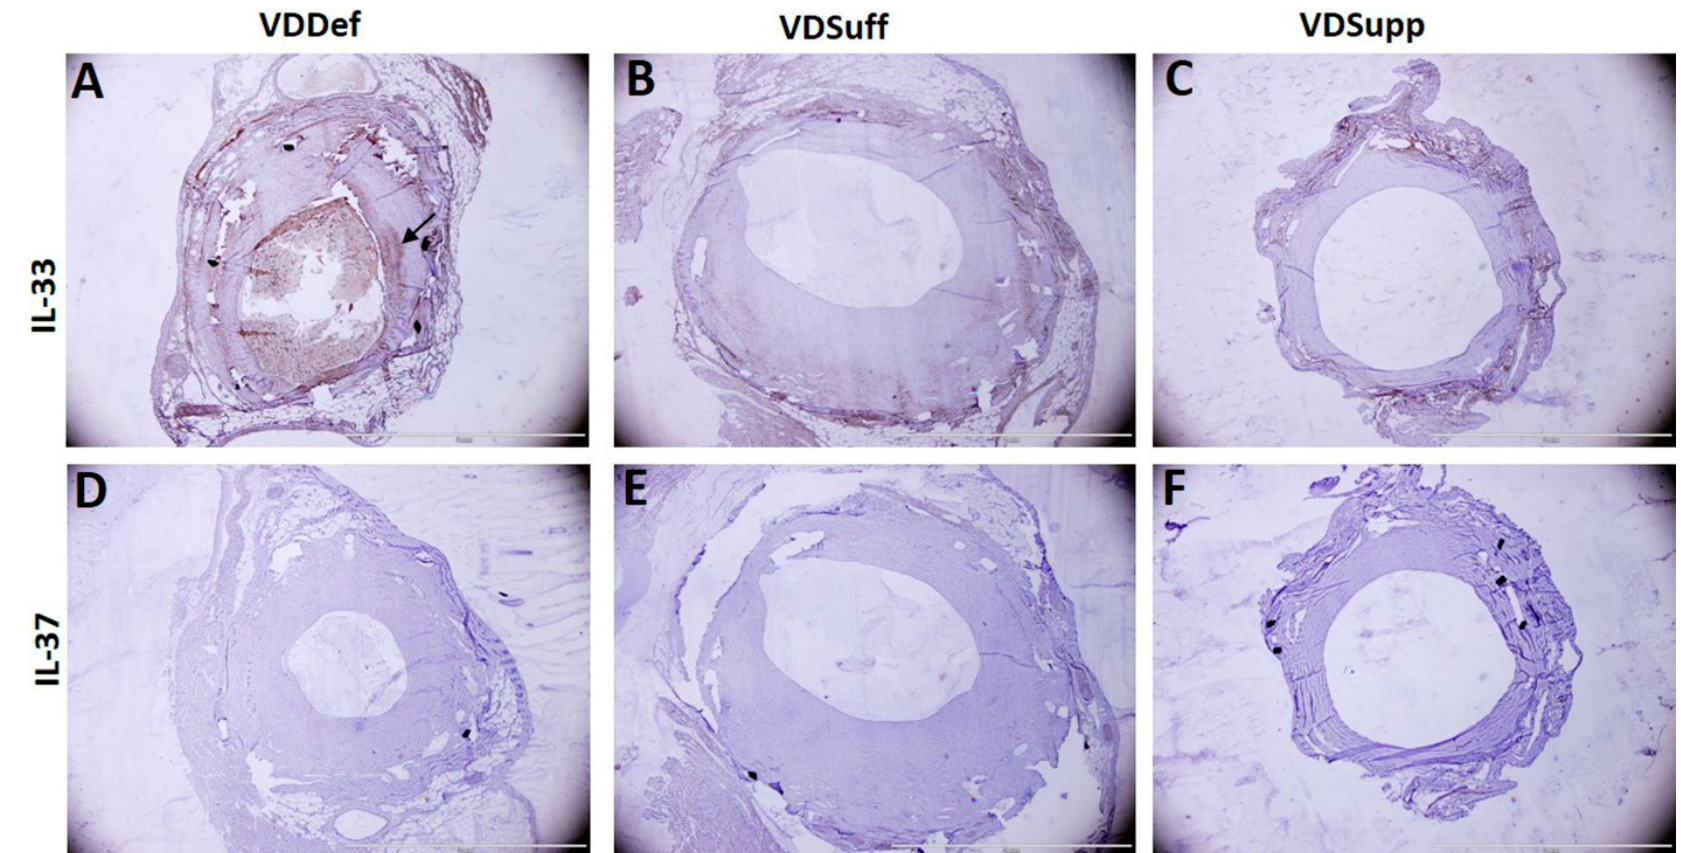
Figure 2. Immunostaining for interleukin (IL)-33 and IL-37 in coronary arteries with a stent in vitamin D deficient, sufficient, and supplemented microswine. IL-33 staining in vitamin D deficient (panel A ), sufficient (panel B ), and supplemented (panel C ) coronary artery with a stent. IL-37 staining in vitamin D deficient (panel D ), sufficient (panel E ), and supplemented (panel F ) coronary artery with a stent. All the images were scanned at 100 μ m.